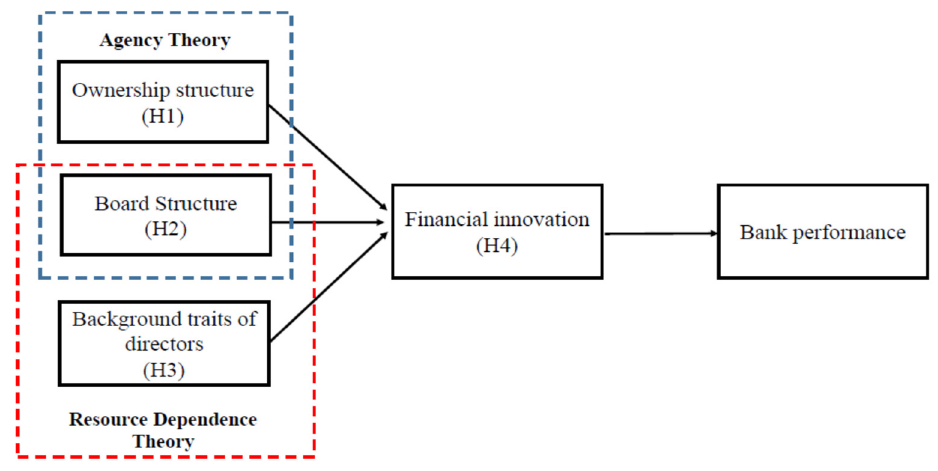
Figure 1. Research model of the relationship between corporate governance, financial innovation and performance.